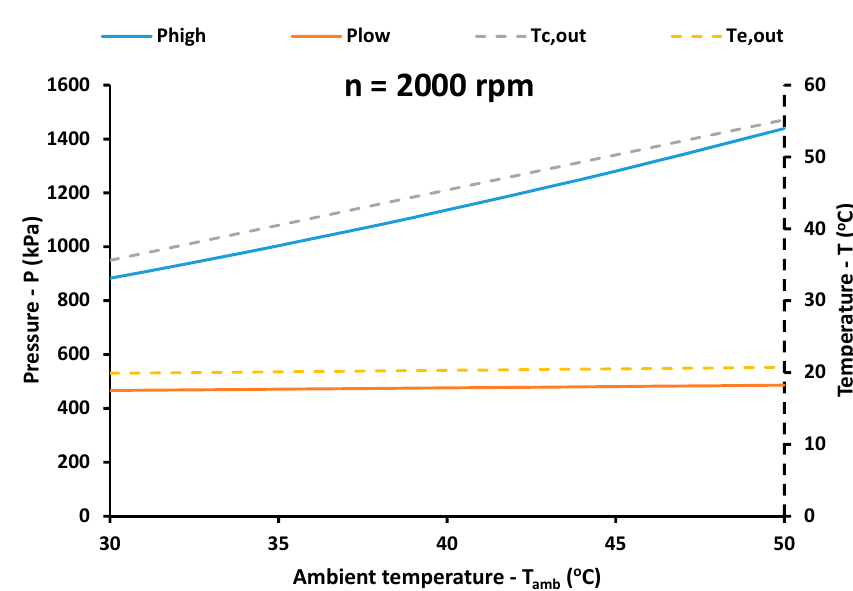
Figure 9. Pressure levels and outlet temperatures of the streams for different ambient temperatures and rotational speeds ( T ind = 25 °C).